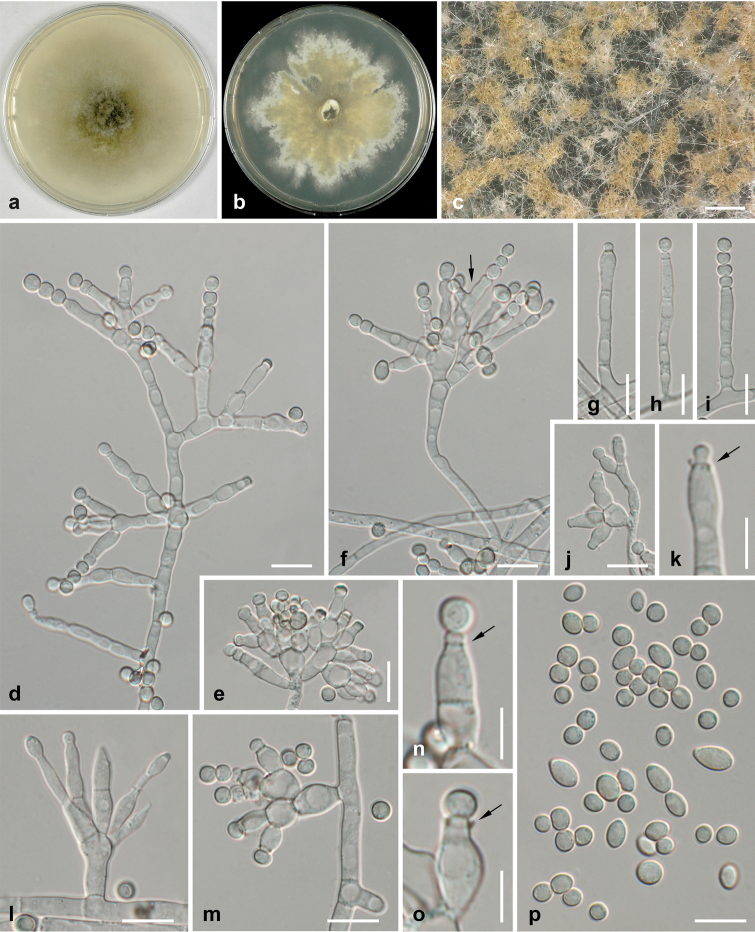
Ochraceocephala
foeniculi, holotype a culture on CMD (7d, 22 °C) b culture on MEA (21d, 22 °C) c conidiophores on aerial hyphae producing yellowish brown conidial masses in chains d–j, l, m unbranched (g–i) and verticillately branched (d–f, j, l, m) conidiophores (MEA, 21d, 22 °C) with phialides; in f with polyphialide (arrow) k, n, o phialides with collarettes (arrows) and young conidia p conidia. All microscopic preparations from MEA (21d, 22 °C) and mounted in water. Scale bars: 200 µm (c); 10 µm (d–j, l, m, p); 5 µm (k, n, o).